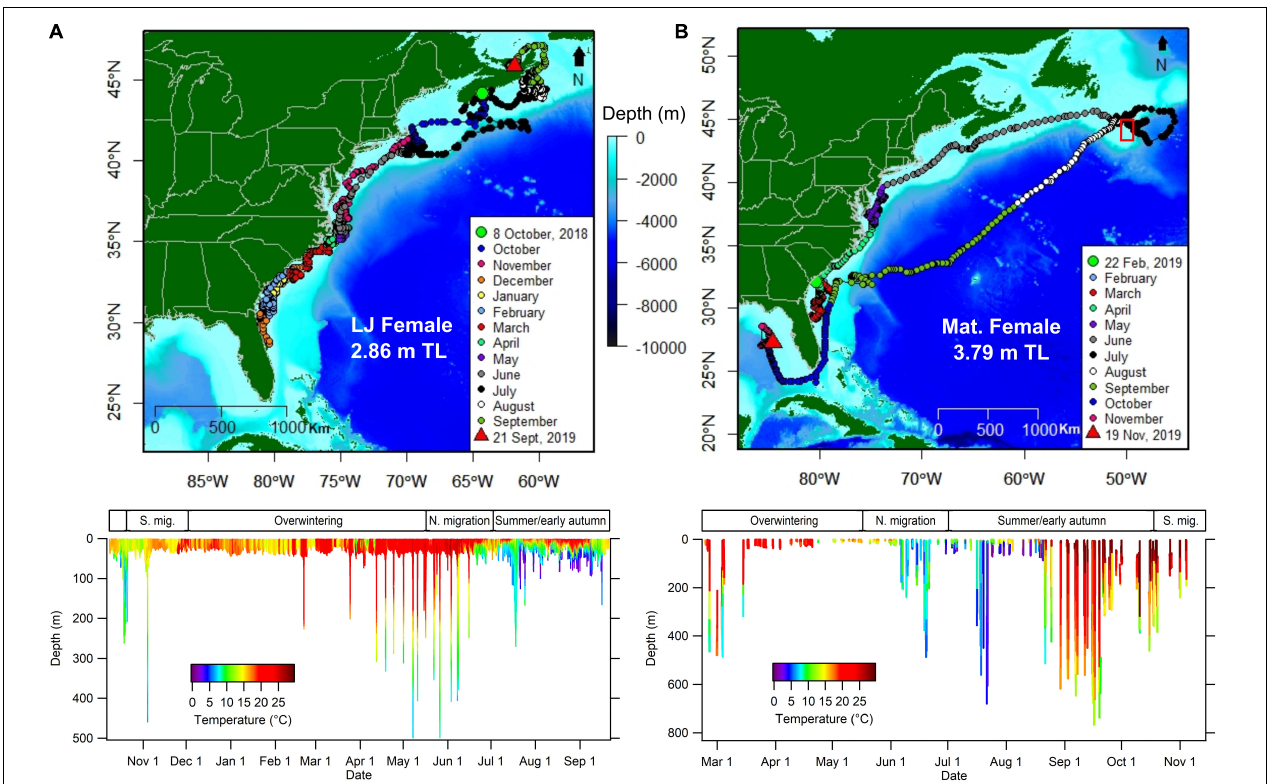
FIGURE 9 | Most probable tracks (MPTs) and depth-temperature profiles derived from PSATs from white sharks NS2018-06 (A) and SE2019-03 (B) . The MPT is a light-based track that incorporated SST, bathymetry, and known locations from SPOT and acoustic tags into the model. The white sharks were tagged off Nova Scotia (A) and South Carolina (B) . The approximate location of the Southeast Shoal is shown as a red box on the Grand Banks of